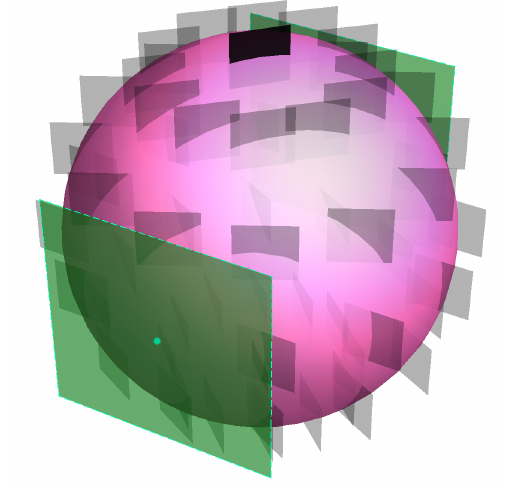
Fig. 5. The tangent planes in green coincide with the contact hyperplanes. Hence, any characteristic vector field must vanish when passing through